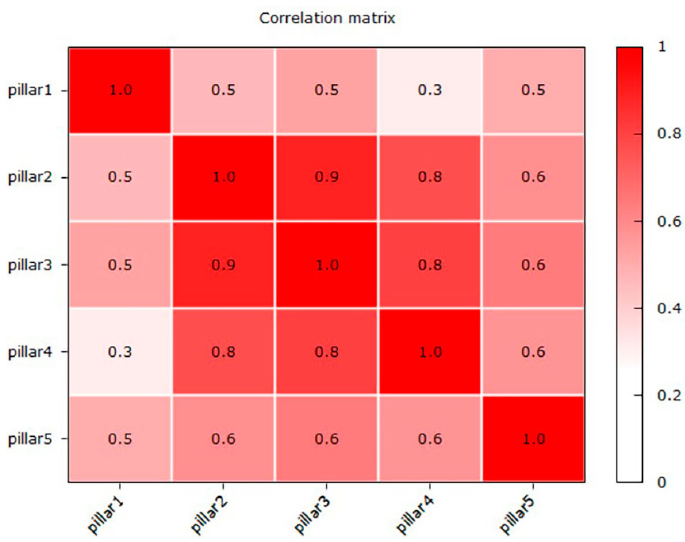
Figure 8. Correlation among pillars in DESI 2020